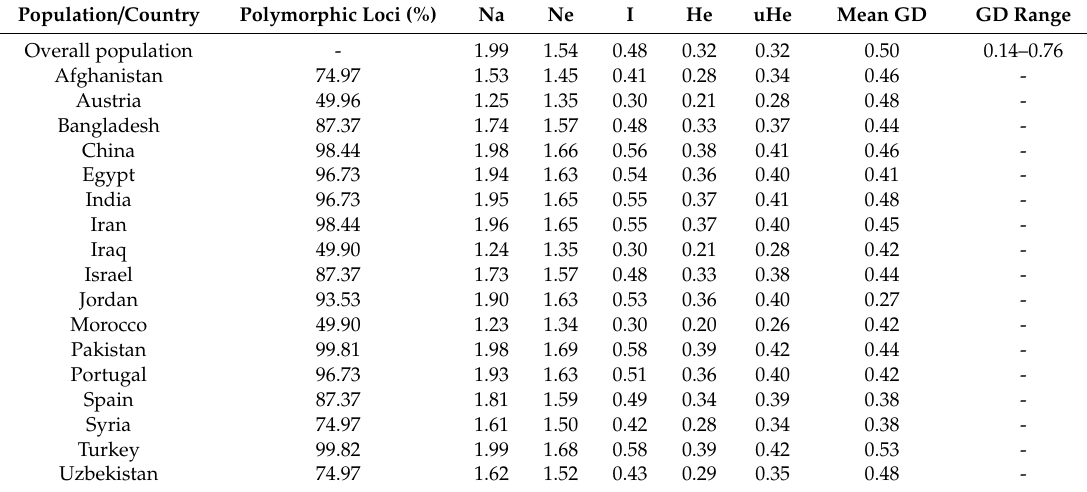
Table 3. Diversity indices calculated to investigate genetic diversity for whole sa ffl ower panel and accessions grouped according to country of origin panel with silicoDArT markers.